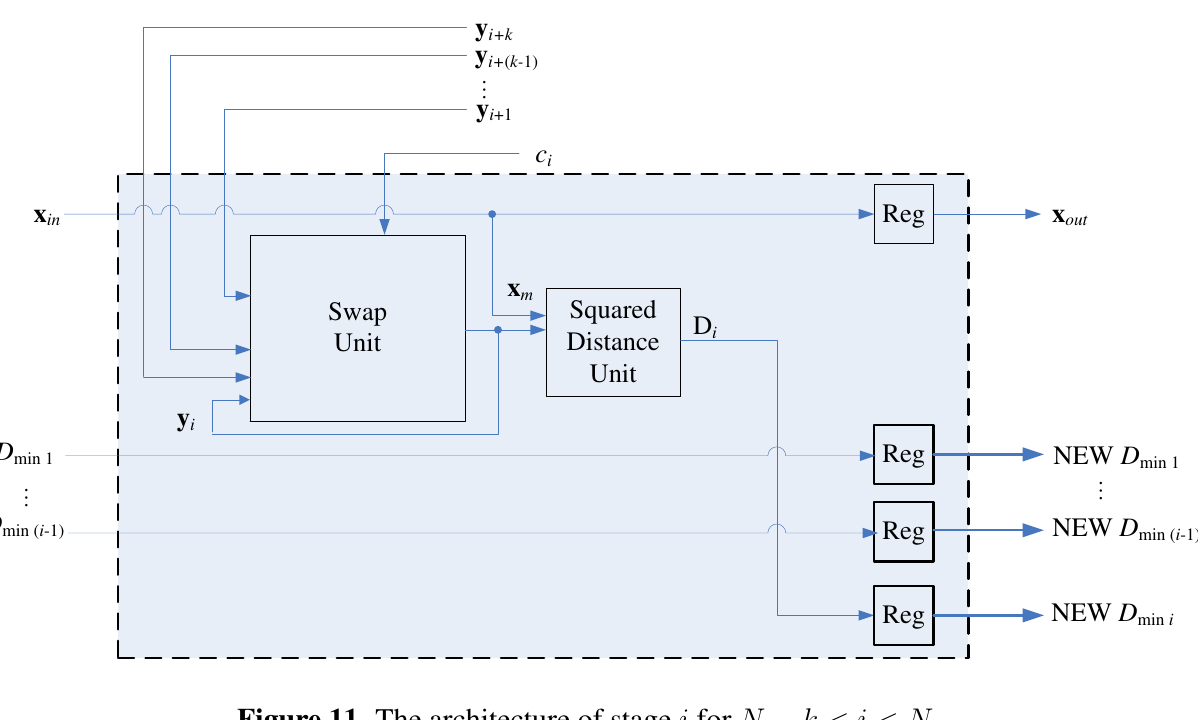
Figure 11. The architecture of stage i for N − k < i < N